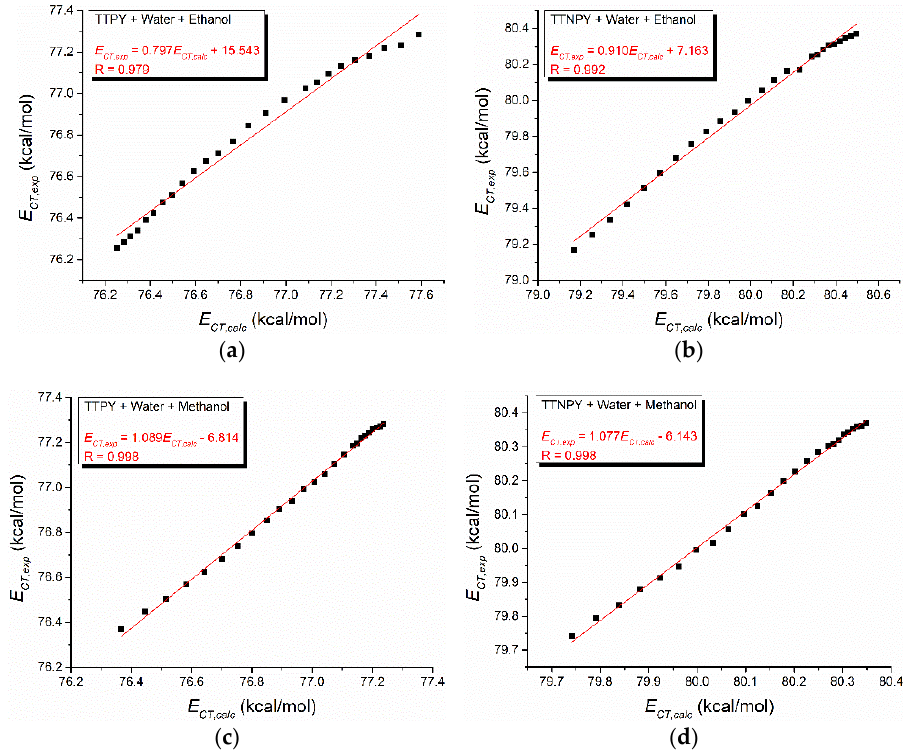
Figure 11. Experimental versus calculated charge transfer energies for 4-tolyl-1,2,4-triazol-1-ium phenacylid (TTPY) ( a , c ) and 4-tolyl-1,2,4-triazol-1-ium-4 ’ -nitro-phenacylid (TTNPY) ( b , d ) in the binary solvent mixtures water + ethanol ( a , b ) and water + methanol ( c , d ). For comparison between the two models (statistical cell model and Suppan), Figure 12 shows the local mole fractions calculated through the statistical cell model ( p 2 ) and Supp an’s model ( y 2 ) as a function of the bulk mole fraction of ethanol and methanol, re- spectively. As can be observed, this figure emphasizes a very good agreement between the two models. ( b ) Figure 12. Local mole fractions calculated through statistical cell model (SCM) ( p 2 ) and Suppan’s model ( y 2 ) as a function of bulk mole fraction of ethanol ( a ) and methanol ( b ), respectively. 4. Materials and Methods The spectrally grade alcohols were purchased from Merck Company and the binary solvent mixtures were realized step by step with molar fractions of 0.05. Bi-distilled water was prepared in our labs. The weighing was repeated twice in order to assure a good precision, having in mind the very small quantities used for each experiment. The weigh- ing was made with a balance having a precision of 0.005 g. The ylids TTPY and TTNPY were prepared [1,2] in the Organic Chemistry Labs of Alexandru Ioan Cuza University and verified from the purity point of view by quantita- tive elemental analysis, Fourier transform infrared (FT-IR) spectroscopy, and 1 H nuclear magnetic resonance (NMR) spectroscopy. The salt method was used to prepare TTPY and TTNPY, the chemical reactions being schematically shown for TTPY in Figure 13; 0.05 mol of 1,2-diformylhydrazine mixed with 0.05 mol of p -Toluidine were refluxed for 8 h. Then, the mixture was kept in room temperature for 24 h. The obtained compound ( p -Tolyl- 1,2,4-triazol-1-ium) was dissolved in 50 mL of chloroform, while 0.05 mol of 2-Bromoace- tophenone was dissolved in 50 mL of benzene. The two solutions were mixed, and potas- sium carbonate was added. The reaction was considered complete when the pH of the